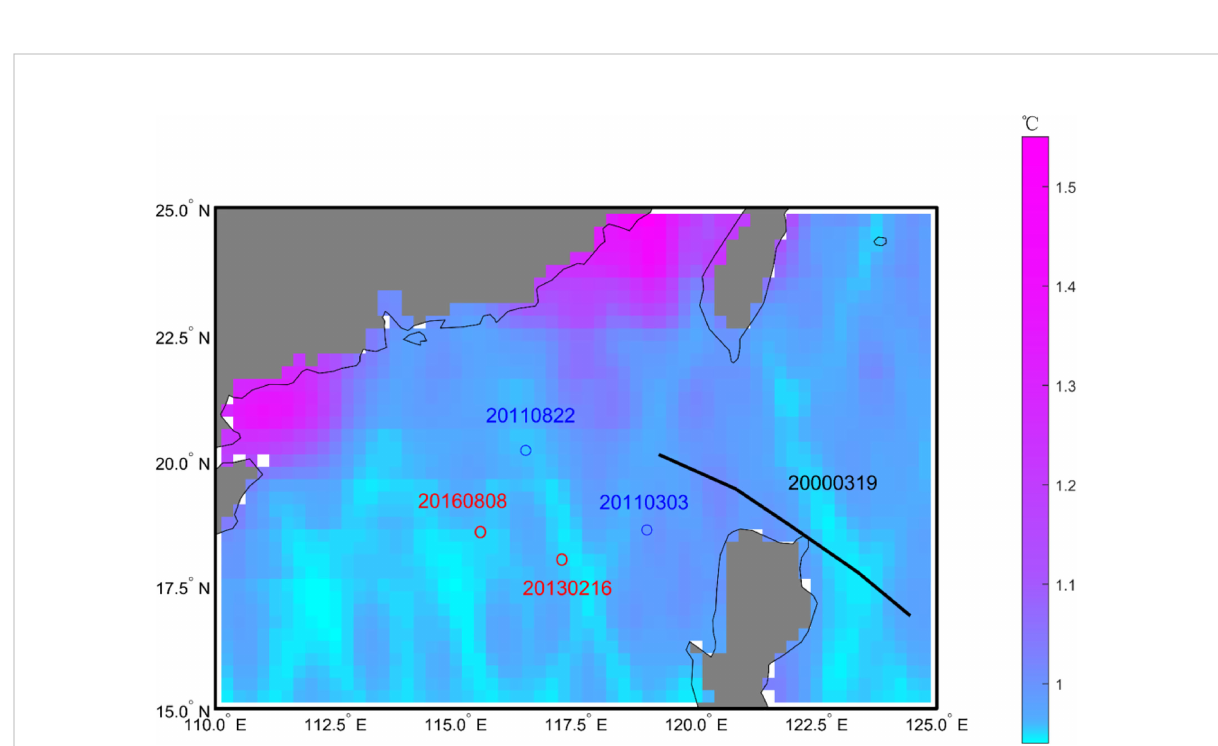
FIGURE 8 Two observation stations and a temperature cross-section. The numbers are dates and the background color is the spatial distribution of maximum temperature errors along the